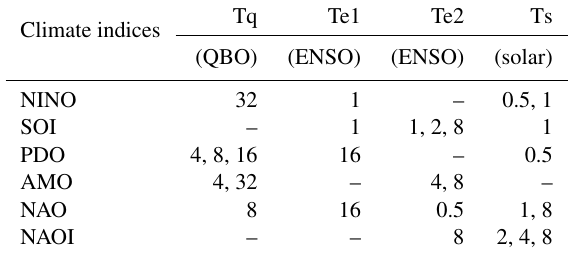
Table 3. The entries in the table show the harmonics of the basic driving forces (significant when affecting an index in more than 10 different embedding dimensions) for each climate mode